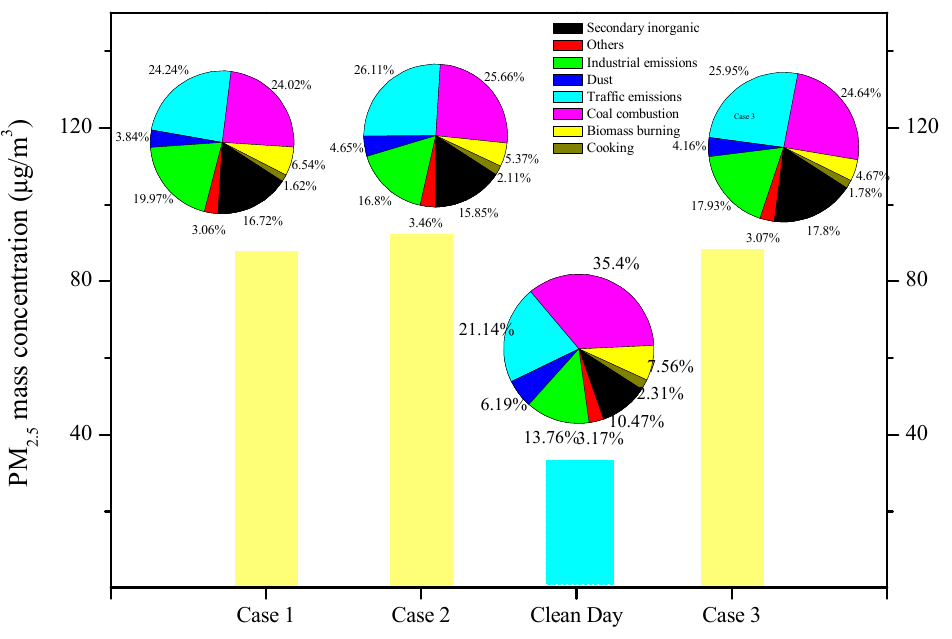
Figure 9. Contribution of eight particle types in the three pollution cases. Compared with other cities, higher PM 2.5 number concentrations often have been identified during haze episodes in Shanghai, and the PM 2.5 mainly consisted of traffic emission particles, biomass burning particles and heavy-duty diesel engine emission